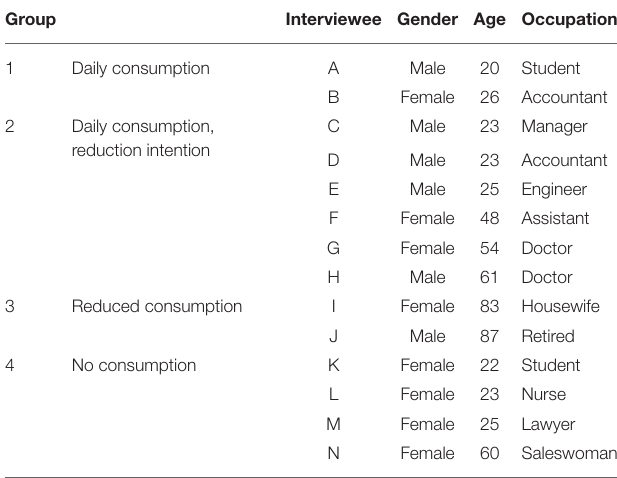
TABLE 1 | Profile of respondents in the qualitative stage. Group Interviewee Gender Age